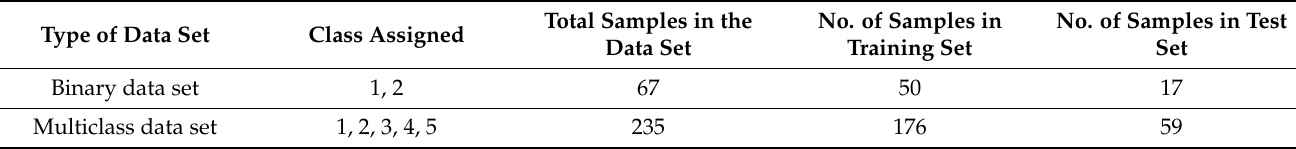
Table 2. Overview of results obtained from duplex showing the attribution of samples (objects) into the training set and test